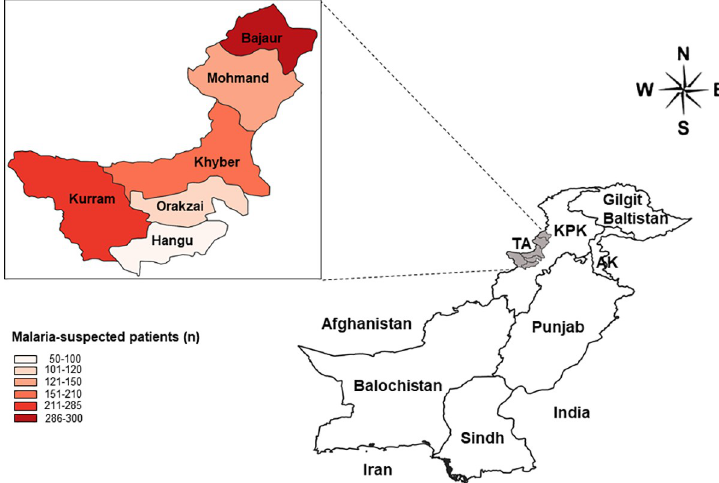
Fig 1. Geographical location of sample collection sites (six districts: shaded grey area) in KPK, Pakistan. The enlarged box shows the prevalence of malaria in each district. KPK: Khyber Pakhtunkhwa, AK: Azad Kashmir, TA: Tribal Areas. The map in this figure was produced using ArcGIS version 10.4. Source of shapefile: United Nations Office for the Coordination of Humanitarian Affairs https://data.humdata.org/dataset/pakistan- administrative-level-0-1-2-and-3-boundary-polygons-lines-and-central-places.